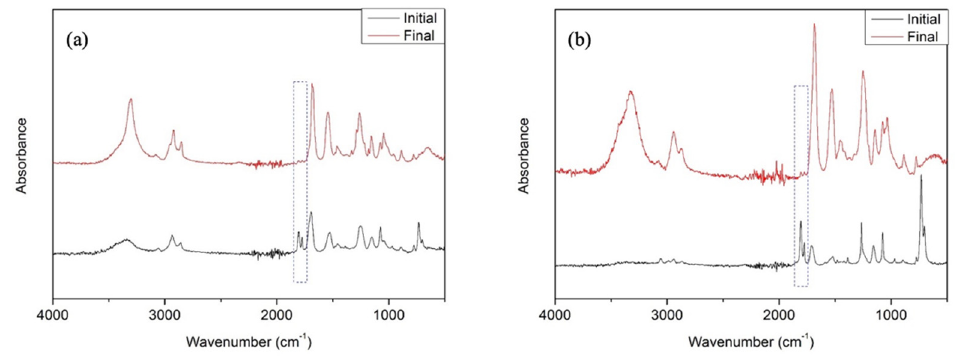
Figure 4. FTIR spectra of the initial reactants (top) and the final product (bottom) in the reaction for ( a ) BHC6 and ( b ) BHC4.